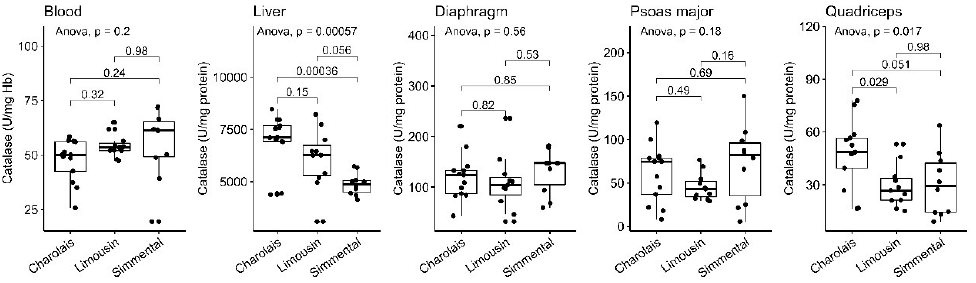
Figure 2. CAT activity in the blood, liver, diaphragm, quadriceps and psoas major of CHA, LIM and SIM cattle .